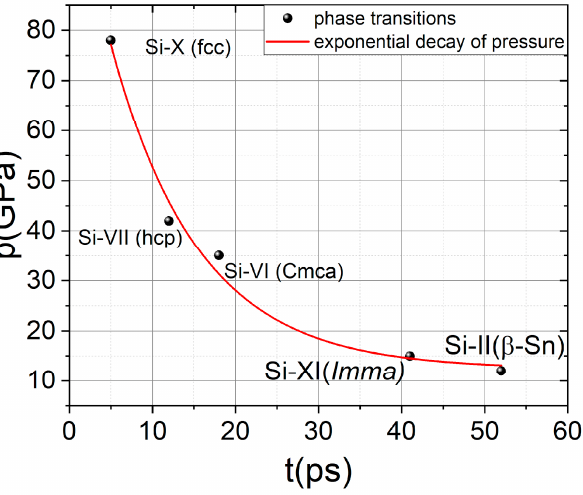
Figure 6. Dependence of the pressure at which a phase transition can occur on the time delay between the pump and probe pulses. The red line marks the exponential pressure decay.